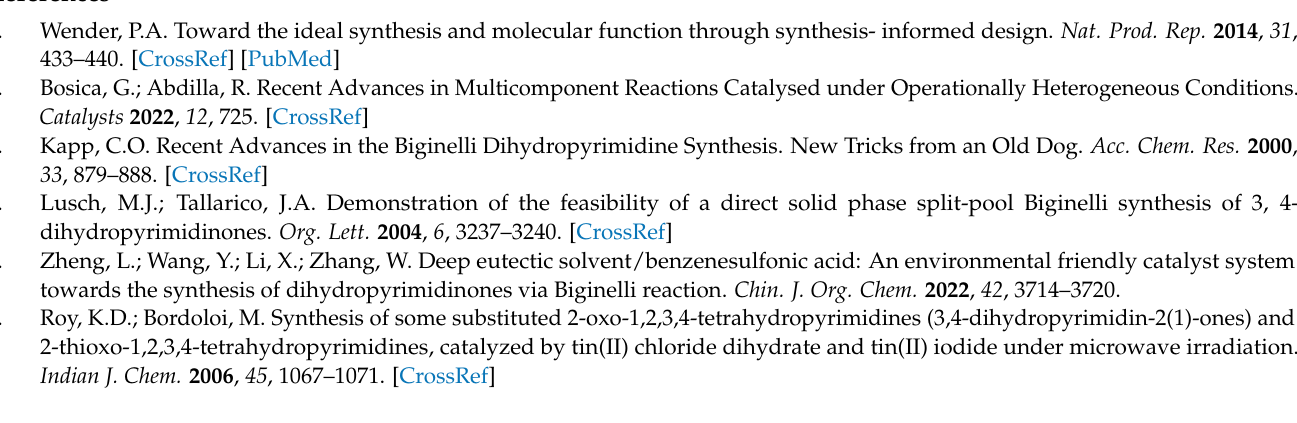
carboxylate; Figure S34: IR spectrum of catalyst 2 after first catalytic cycle; Figure S35: UV-visible spec- trum of catalyst 2 recorded in Nujol after first cycle; Table S1: Elemental mapping data from EDX